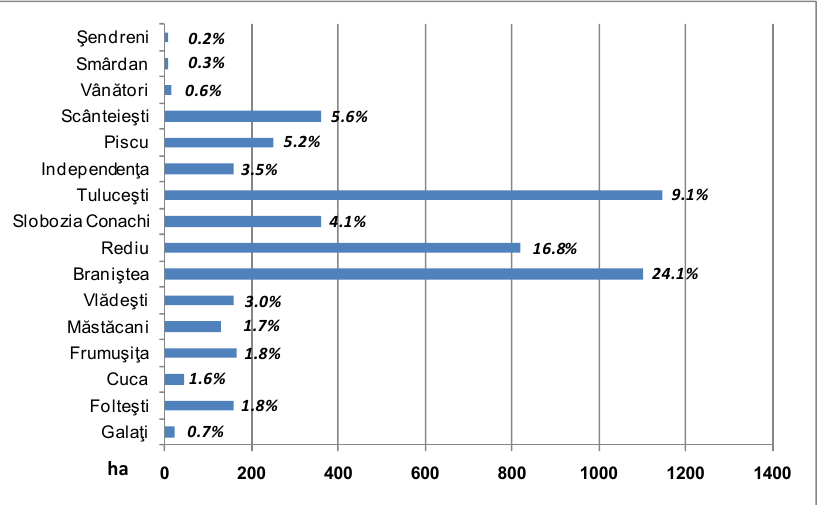
Figure 11. Forest area (ha) and the afforestation percentage (%) by local administrative units (January 1947) in the peri-urban area of Gala¸ti, after the Statistical Directory of Covurlui County [67]. The highest afforestation shares were recorded in Brani¸stea and Rediu communes (24.1% and 16.8%, respectively). However, in 1947, the overall peri-urban area of